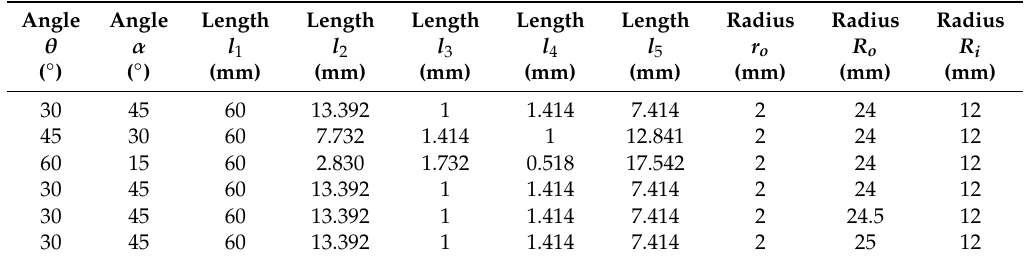
Table 5. Structural